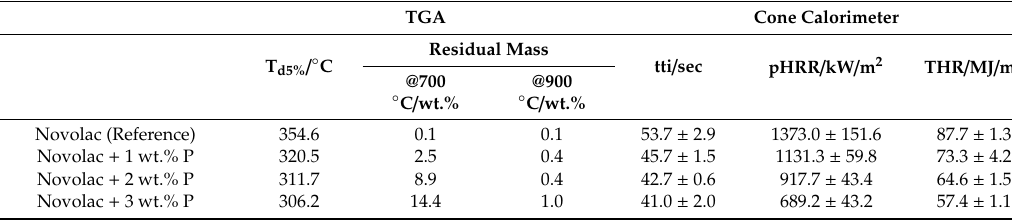
Figure 2. TGA measurement under air atmosphere (left) and cone calorimeter test (right; 50 kW/m 2 and distance sample to heater: 60 mm) of the DOPO modified epoxy resin. Table 2. T d5% , residual mass @700 °C and @900 °C from TGA under air atmosphere and time to ignition (tti), peak heat release rate (pHRR) and total heat release (THR) from cone calorimeter experiments for DOPO modified epoxy resins.